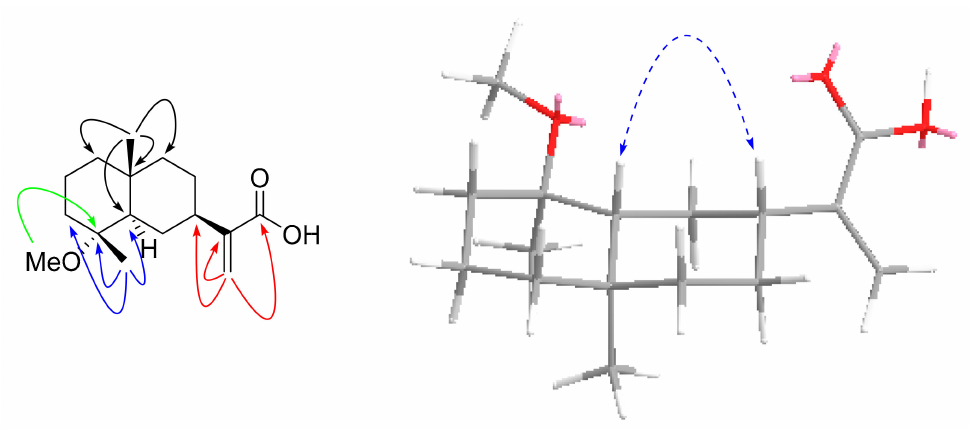
Figure 12. Key HMBC ( → ) and ROESY ( ↔ ) correlations for Compound 5 .